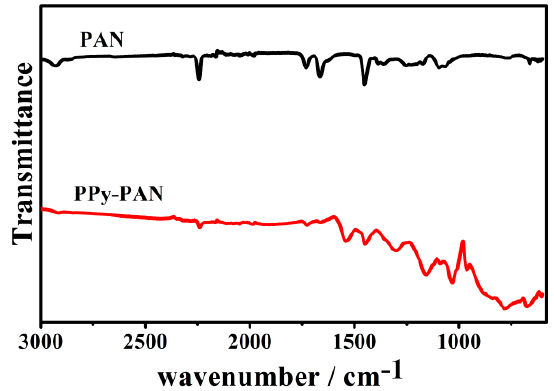
Figure 2. Fourier transform infrared spectroscopy (FTIR) spectra of PAN and PPy–PAN coaxial nanofiber yarn.